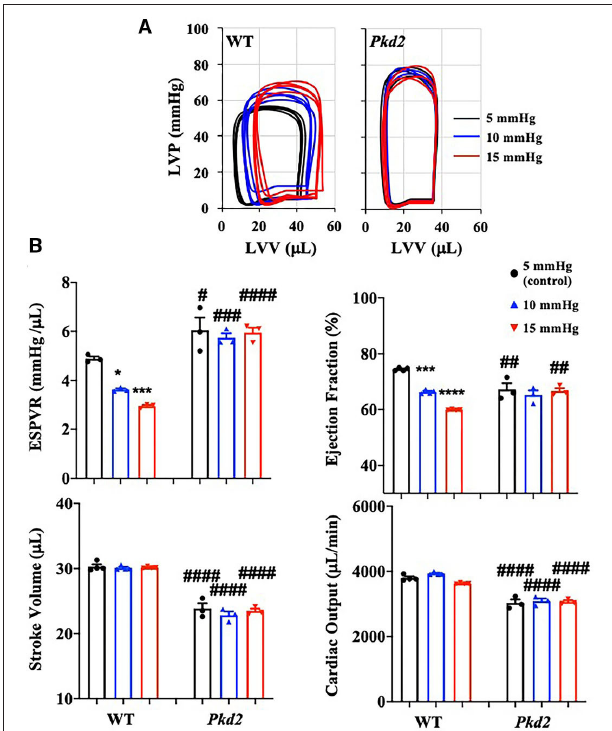
FIGURE 6 | The cardiac function of Pkd2 -KO mice is not responsive on changes in preloads. (A) Individual graphs of pressure-volume loop show effects of different preloads of 5, 10, and 15 mmHg on heart function. (B) End-systolic-pressure-volume relationship (ESPVR, an index of systolic contractility function), stroke volume, ejection fraction, and cardiac output are used to measure heart functions in response to different pre-load levels. N = 3–4 mice for each WT and PKD age-matched 6 months old. Statistical significance between control and treatment is indicated with asterisk (*) sign; between genotypes in hash (#). * p < 0.05; *** p < 0.001; **** p < 0.0001; # p < 0.05; ## p < 0.01; ### p < 0.001; #### p <